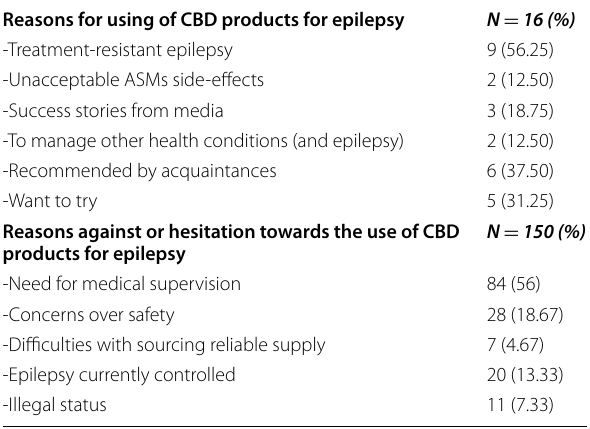
Table 4 Reasons for using and against using cannabidiol products to manage